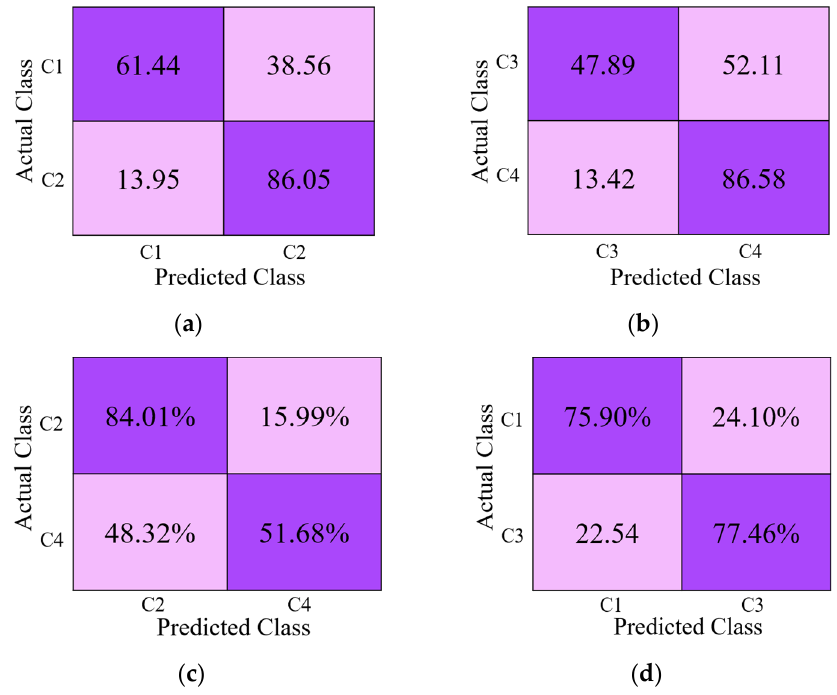
Figure 15. Performance of the proposed network considering open-world setting as confusion matrices ( a ) 1st fold-A (using C1 and C2 in testing), ( b ) 1st fold-B (using C3 and C4 in testing), ( c ) 2nd fold-A (using C2 and C4 in testing), and ( d ) 2nd fold-B (using C1 and C3 in testing). Table 16. Comparison of our proposed model with the second- and third-best models of Table 13 for open-world configuration (unit: %).